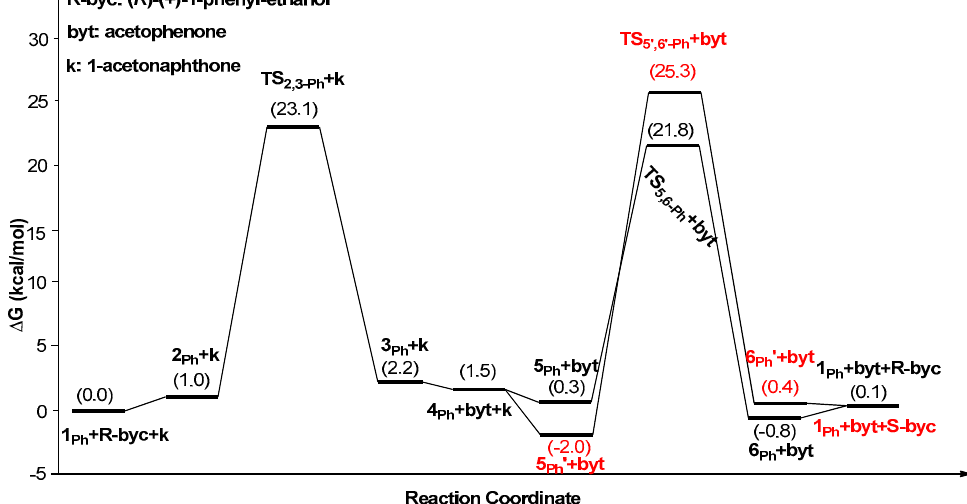
Figure 2. Free energy profile for the asymmetric transfer hydrogenation of 1-acetonaphthone catalyzed by 1 Ph .